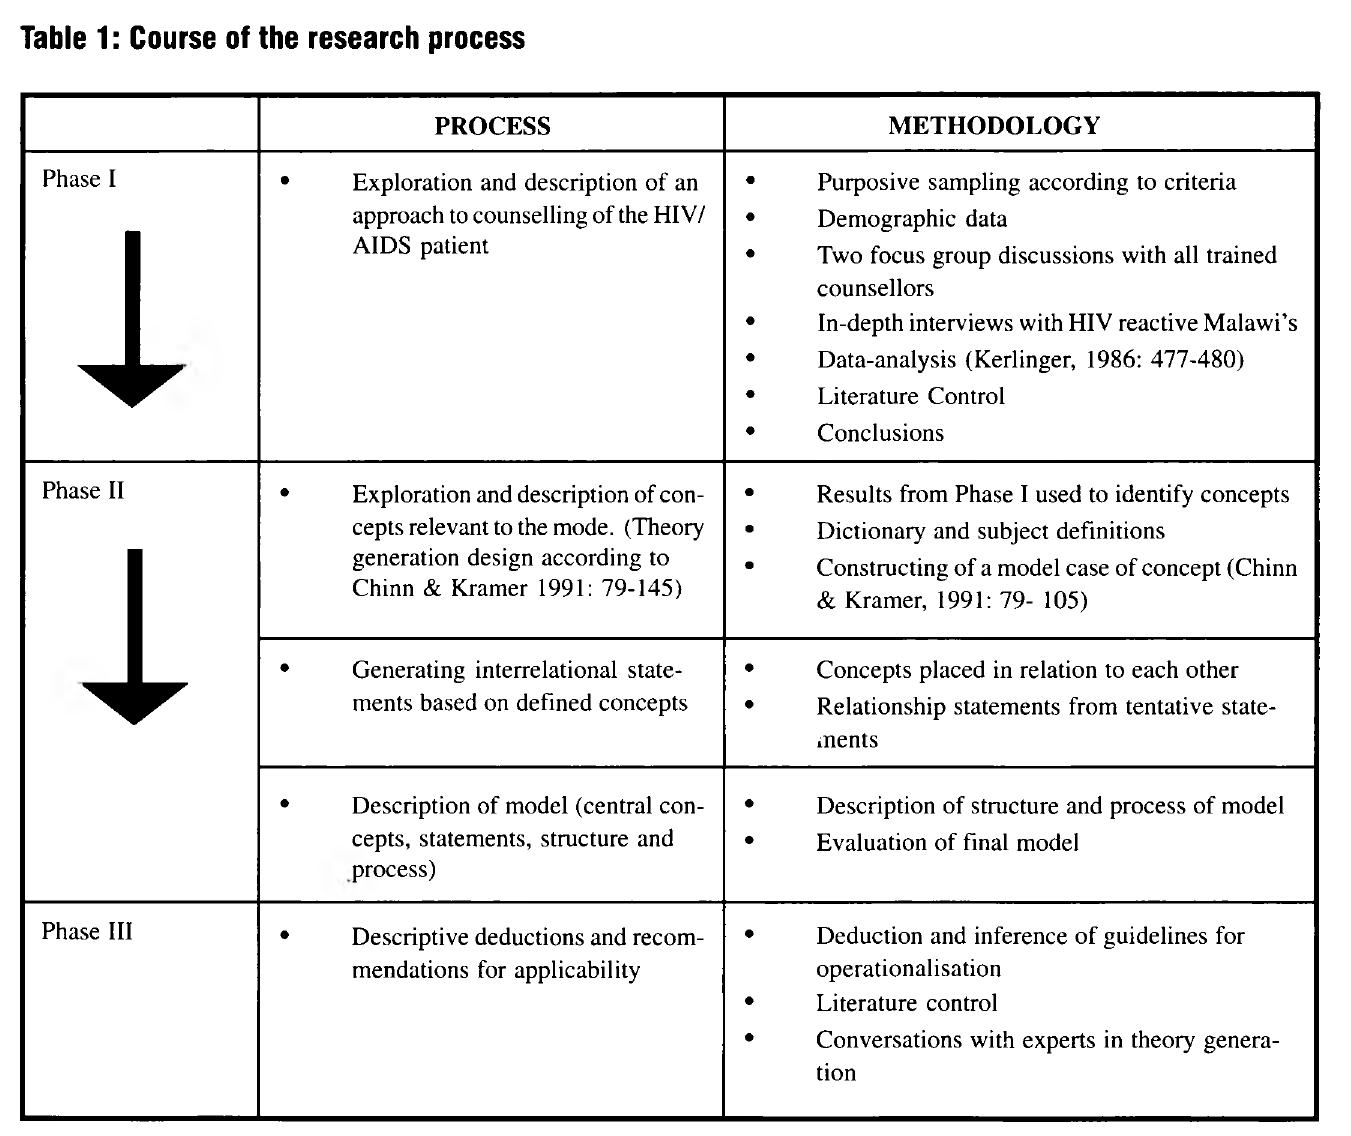
Table 1 : Course of the research